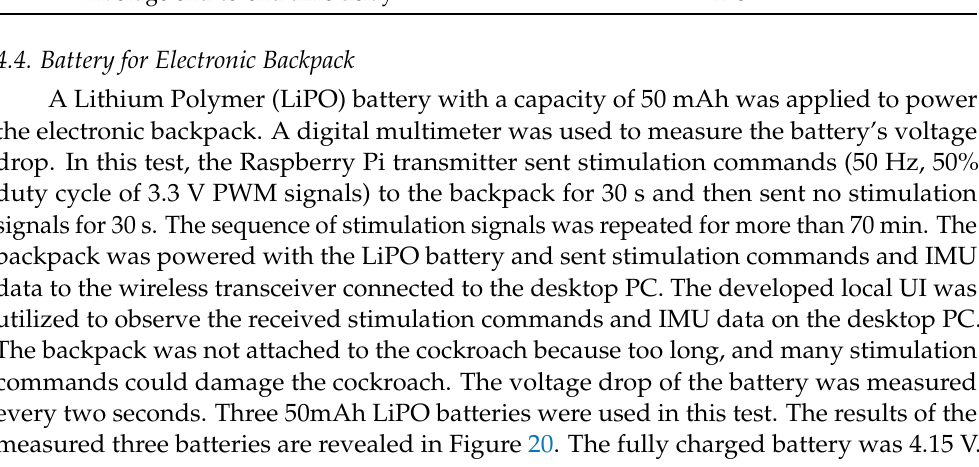
Figure 19. The measured time delay in local wireless communication.